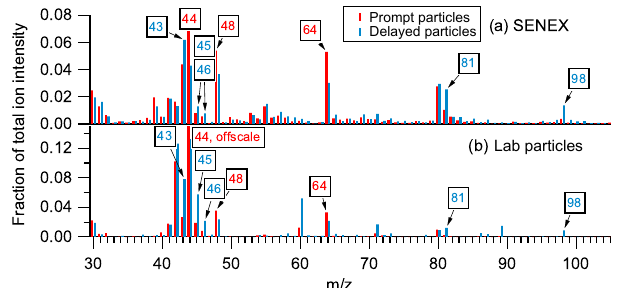
Figure 4. (a) Average mass spectrum (in total ion intensity fraction) of prompt (red) and delayed (blue) particles for the SENEX flights analyzed. The average prompt and delayed spectrum are shifted − 0 . 2 and + 0 . 2 units, respectively, in m/z for display clarity. (b) Average mass spectrum (in total ion intensity fraction) of prompt (red) and delayed (blue) laboratory particles composed of internally mixed organic dicarboxylic and carbonyl acids, ammonium organic acid salts, ammonium sulfate, and ammonium